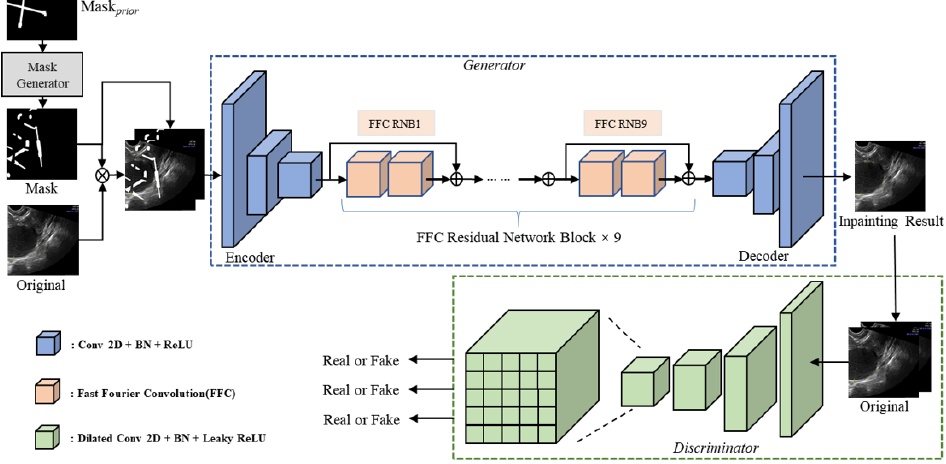
Figure 5. The overall architecture of our MGGAN model. The generator consists of 9 FFC Residual Network Blocks with our mask to a priori guide the generator for image